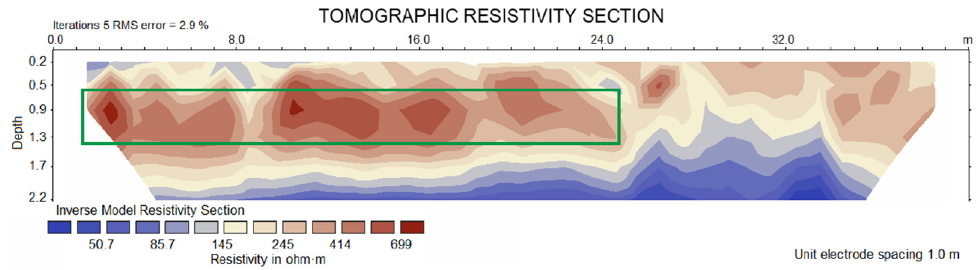
Figure 16. Tomographic resistivity section measured in the same area.